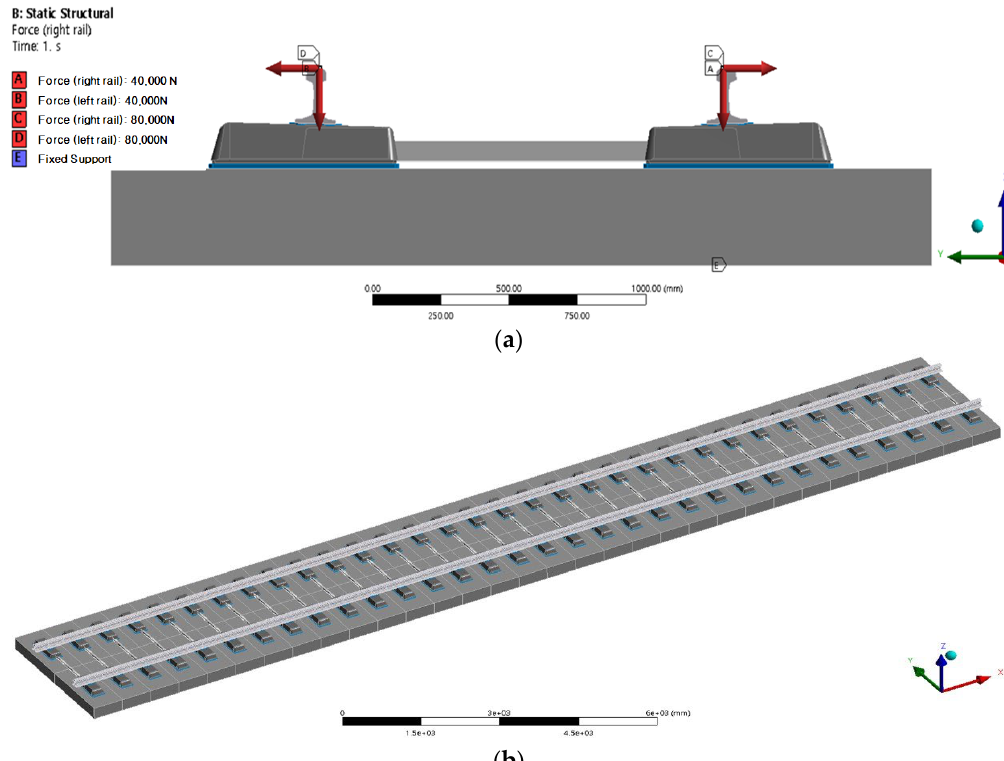
Figure 4. FE model of the booted sleeper track system: ( a ) load and boundary conditions for model verification; ( b ) full